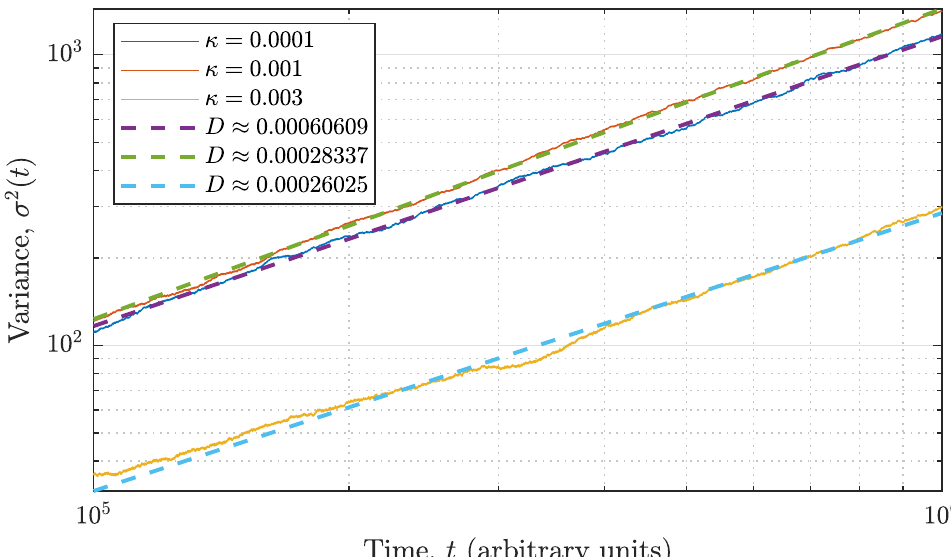
Figure 6. Logarithmic representation of variance σ 2 ( t ) for different values of κ . The ordinates at the origin of the fitted straight lines represent the diffusion coefficients D , while their slopes approximate to the unit indicating normal